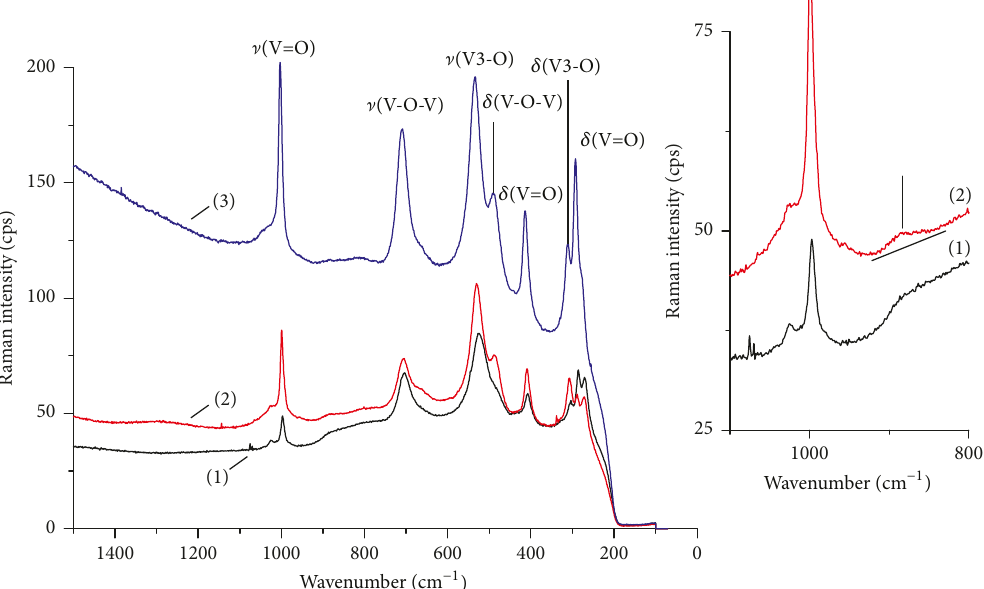
Figure 8: Raman spectra of crystalline V 2 O 5 : (1) initial film, (2) hydrogenated region, and (3) region colored at the IECE. Specific bending ( 𝛿 ) and stretching ( ] ) vibration modes from the works [21–23] are